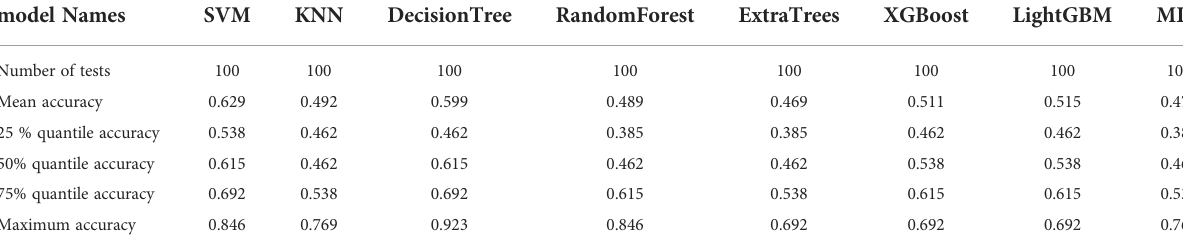
TABLE 11 Distribution of the accuracy of each model randomly tested 100 times by eight common machine learning algorithms. model Names